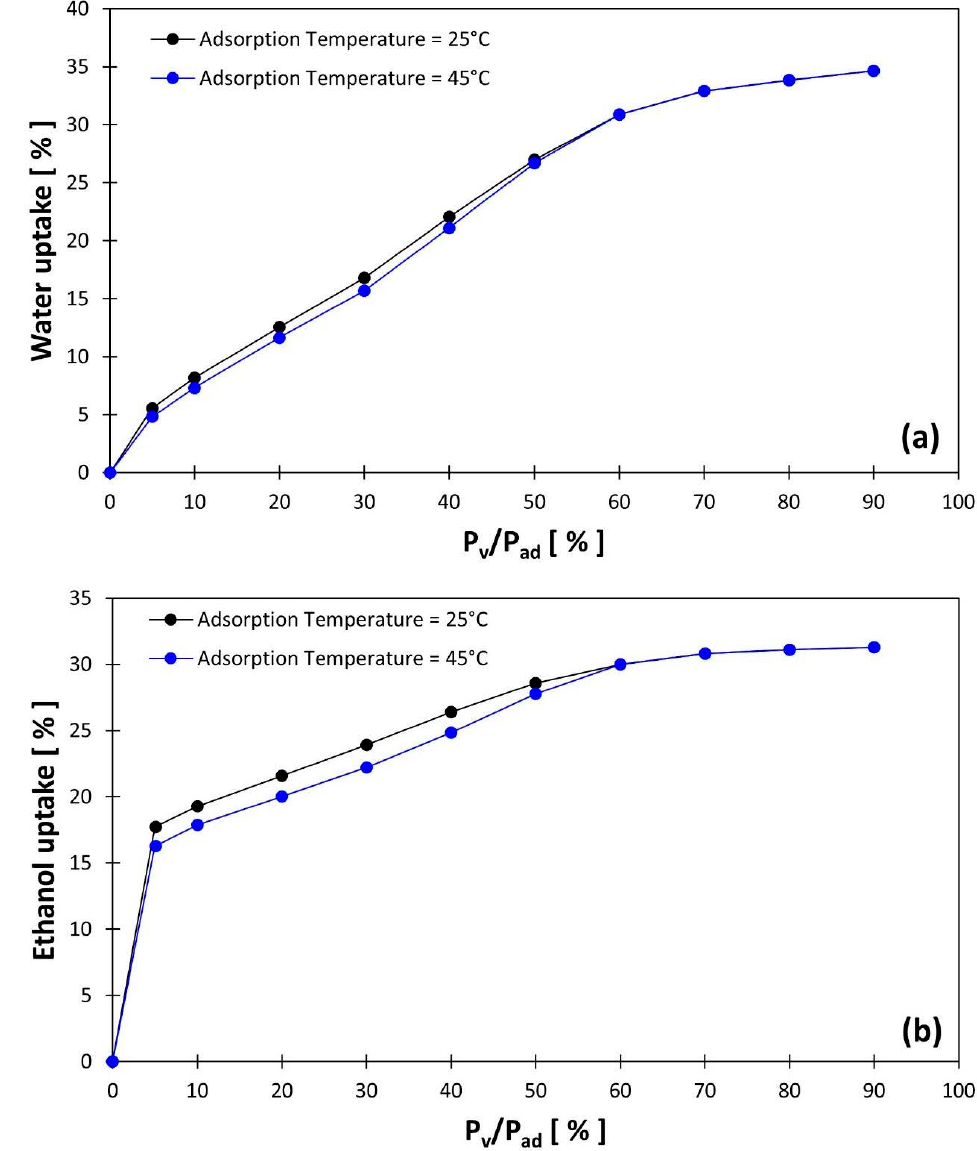
Figure 4. Adsorption isotherms for ( a ) silica gel/water and ( b ) silica gel/ethanol.